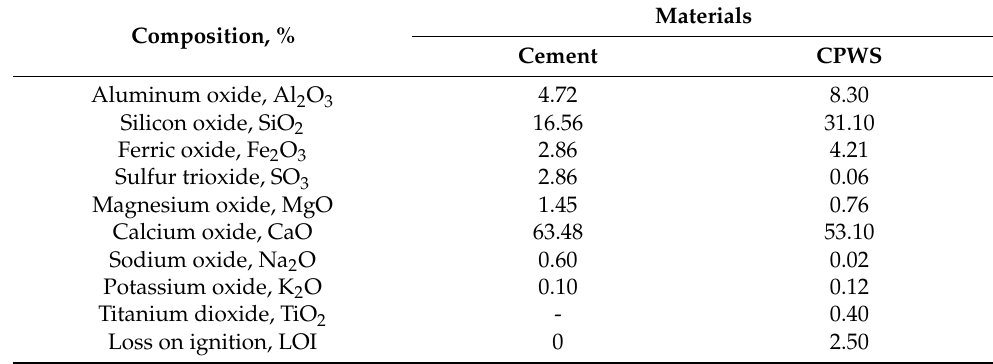
Table 2. Chemical composition of cement and